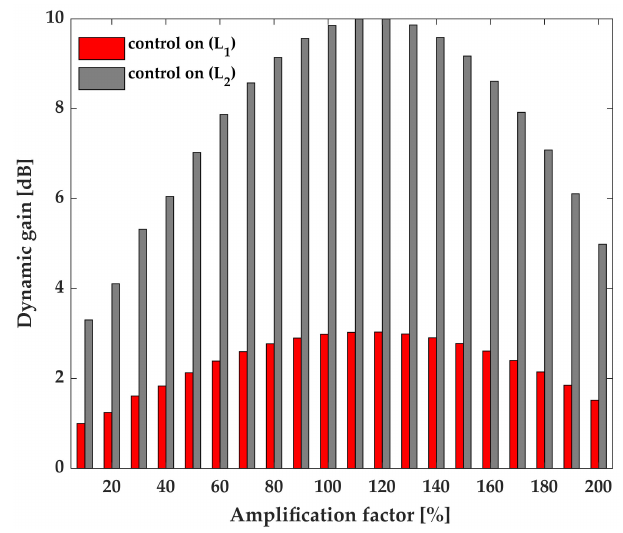
Figure 9. Maximum dynamic gain: piezo actuator saturation.